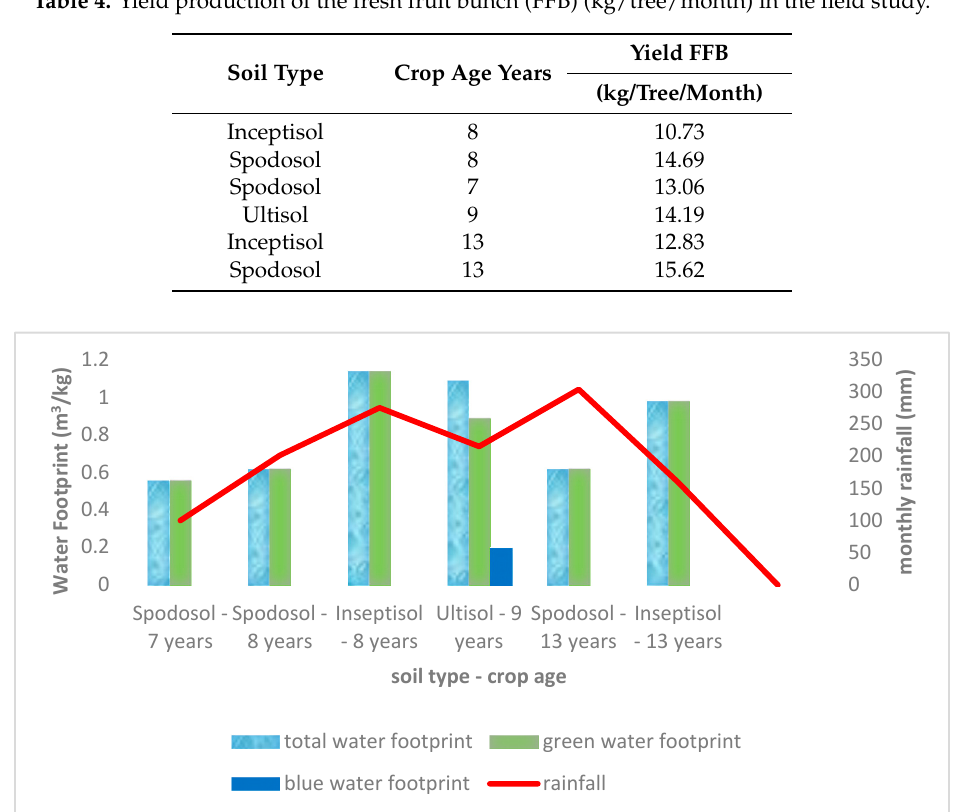
Figure 4. Oil palm water footprint (m 3 /kg FFB) for varying crop ages and soil types.